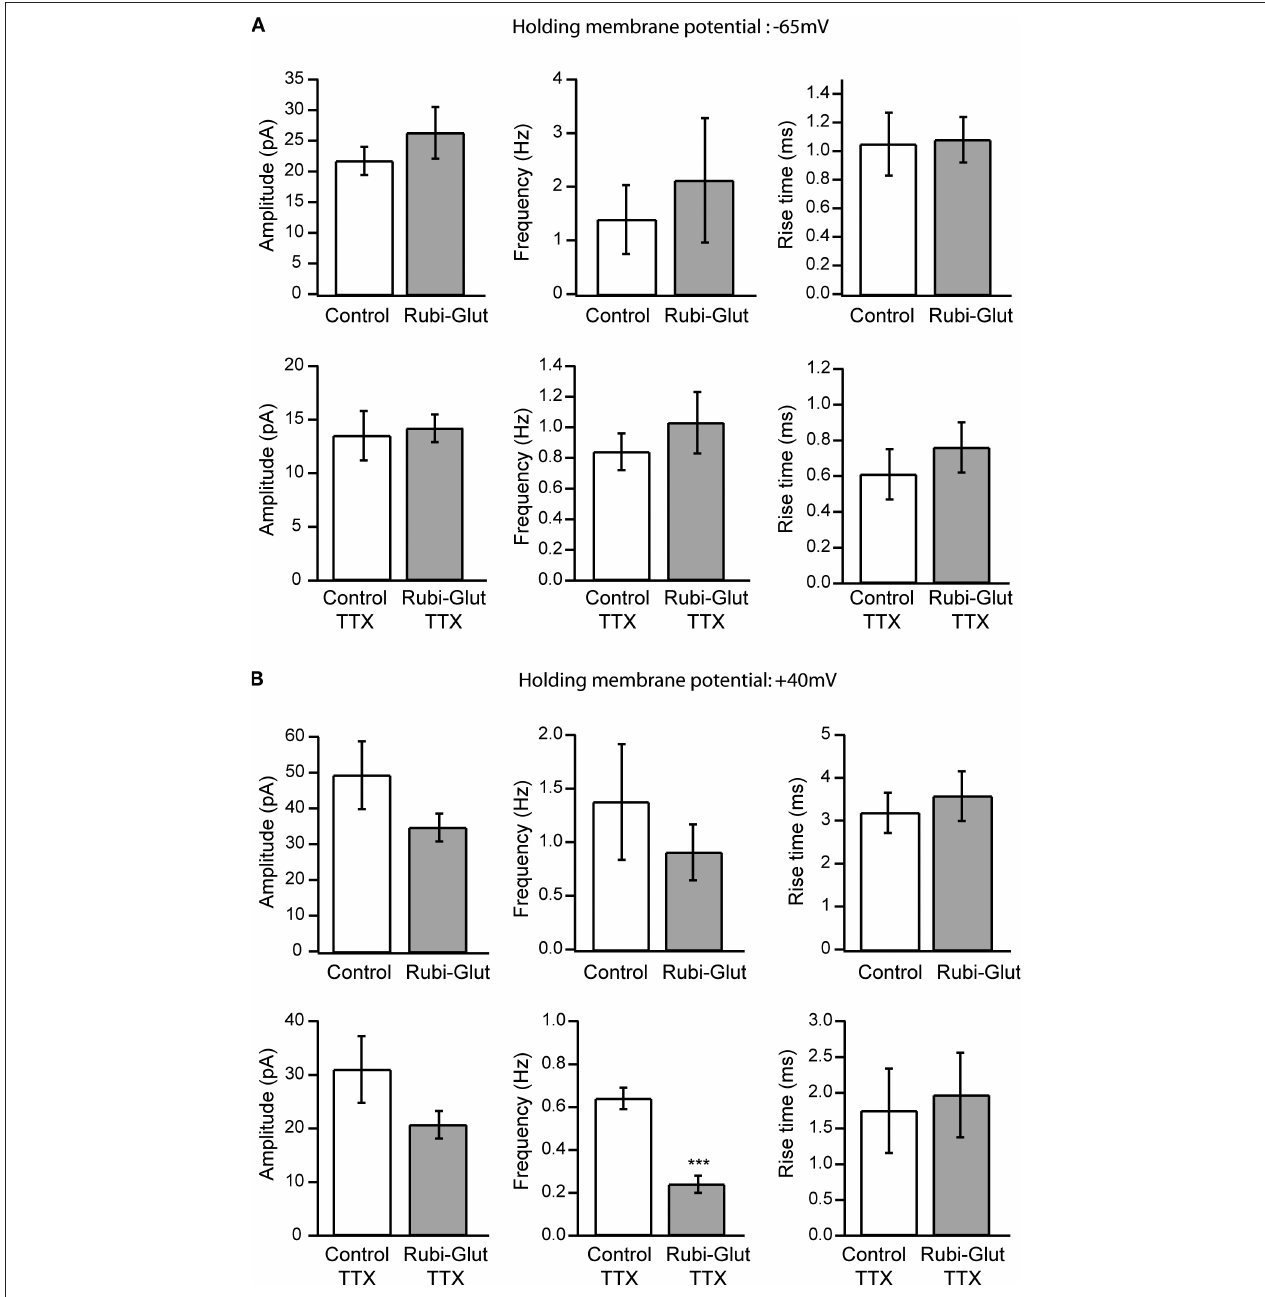
FIGURE 2 | Effect of RuBi-Glutamate on spontaneous synaptic currents. (A) Effects of RuBi-Glutamate on spontaneous activity recorded at a holding membrane potential of − 65 mV. At this resting potential, RuBi- Glutamate (300 µM) had no signifi cant effect on the average amplitude, frequency or rise time of spontaneous PSCs ( n = 6 neurons) or of miniature PSCs recorded in the presence of TTX ( n = 6 neurons). (B) Effects of RuBi-Glutamate on spontaneous activity recorded at + 40 mV.